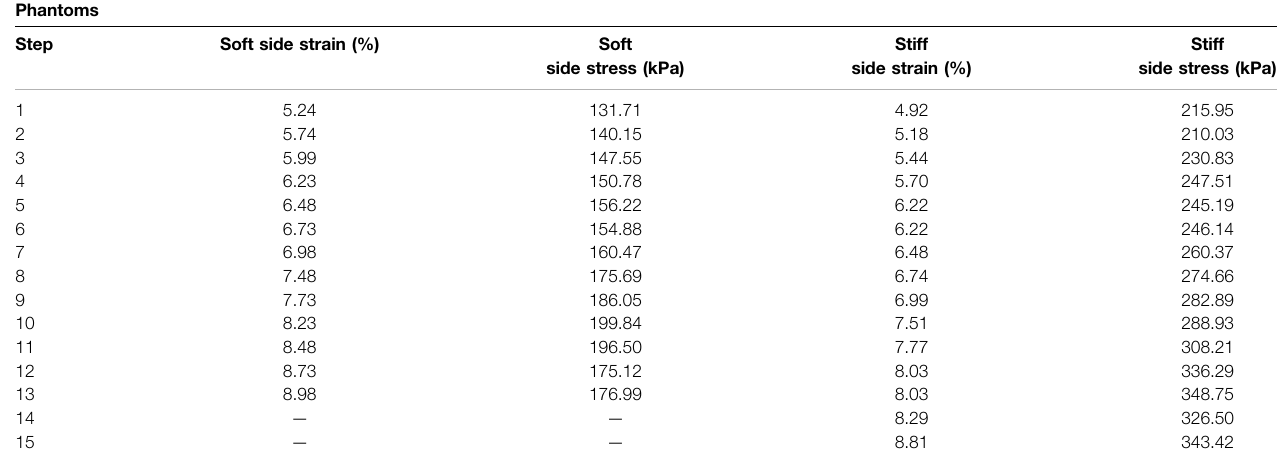
TABLE 1 | Values of stress and strain for the soft and stiff sides of the phantom experiment.